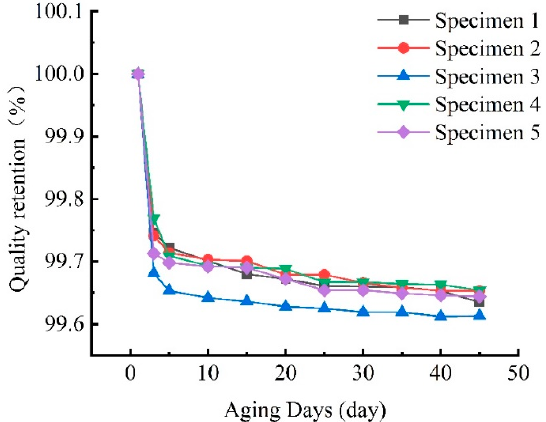
Figure 9. The relationship curve between mass retention rate and time under UV irradiation.